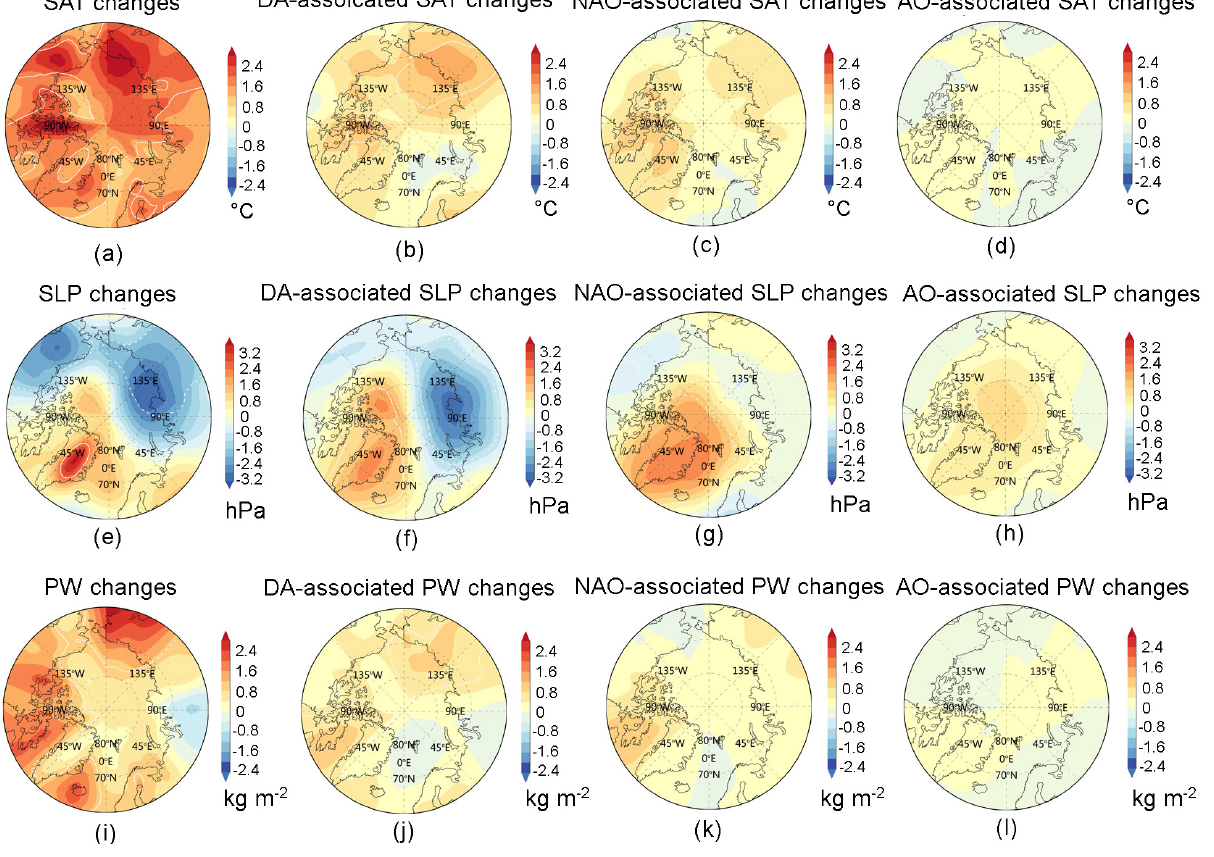
Figure 14. The changes in typical climate variables (SAT, SLP, and PW) over the 1979–2016 period (the first column, panels a , e , and i ). The change is obtained by multiplying the trend estimate (regression map) and the time span of the period (i.e., 38 years). The regressions of these climatic variables on the DA (the second column, panels b , f , and j ), NAO (the third column, panels c , g , and k ), and AO (the fourth column, panels d , h , and l ) are also presented.